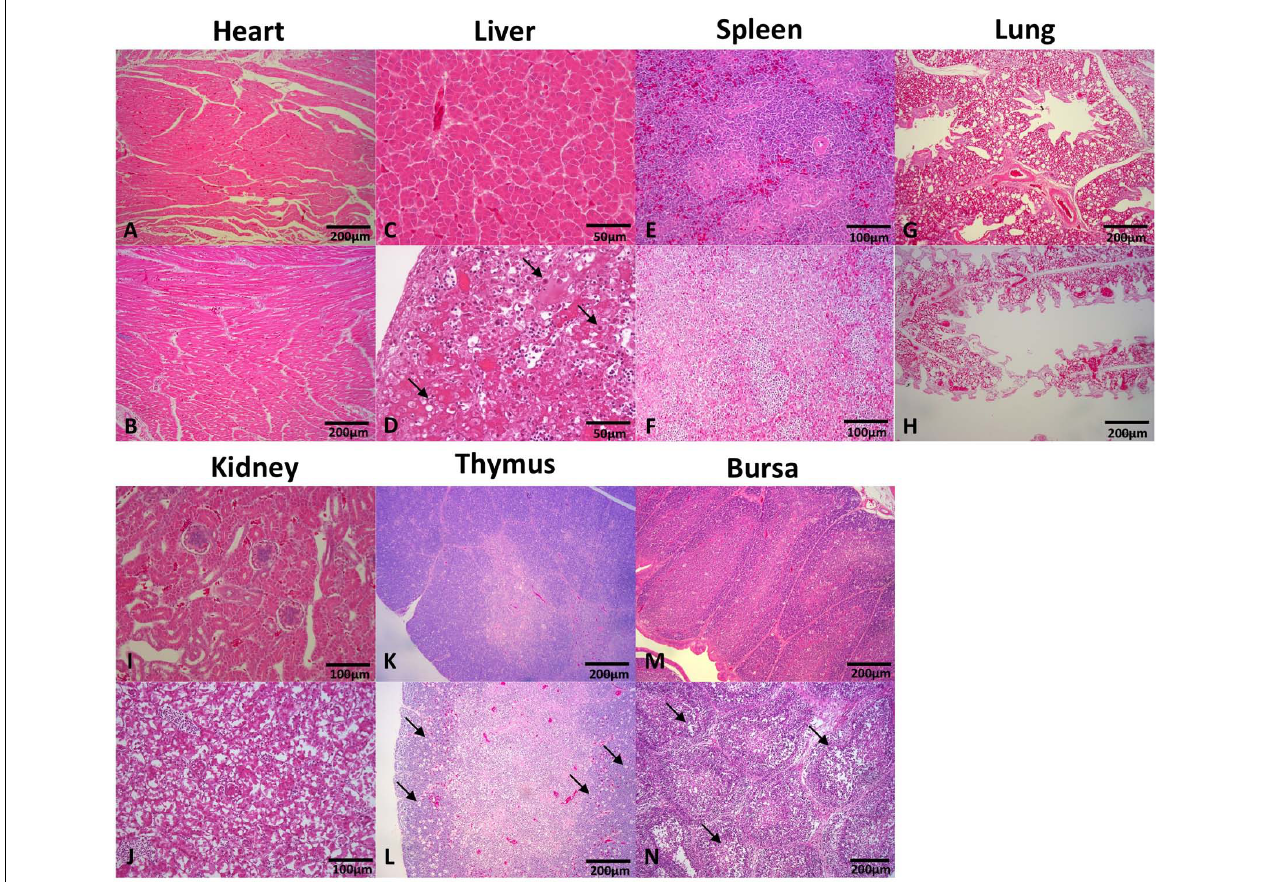
FIGURE 3 | Histopathology in tissues from dead chickens inoculated with HLJDAd15. Tissues in infection and control groups were collected, fixed, cut into sections, and stained with HE. Generally, there was no significant histopathology damages presented in the heart (A) , liver (C) , spleen (E) , lung (G) , kidney (I) , thymus (K) , and bursa (M) of chickens in control group, while massive pathological damages were observed in various tissues of chickens in infection group: (D) degeneration, vacuolar necrosis and basophilic inclusion bodies presented in liver cells; (J) large numbers of vacuolar necrosis showed in kidney cells; (L) large numbers of macrophages proliferation and cortical lymphocyte depletion appeared in thymus; severe reduction and necrosis of lymphocytes showed in spleen (F) and bursa (N) ; no significant differences were observed in heart (B) and lung (H) compared with the control